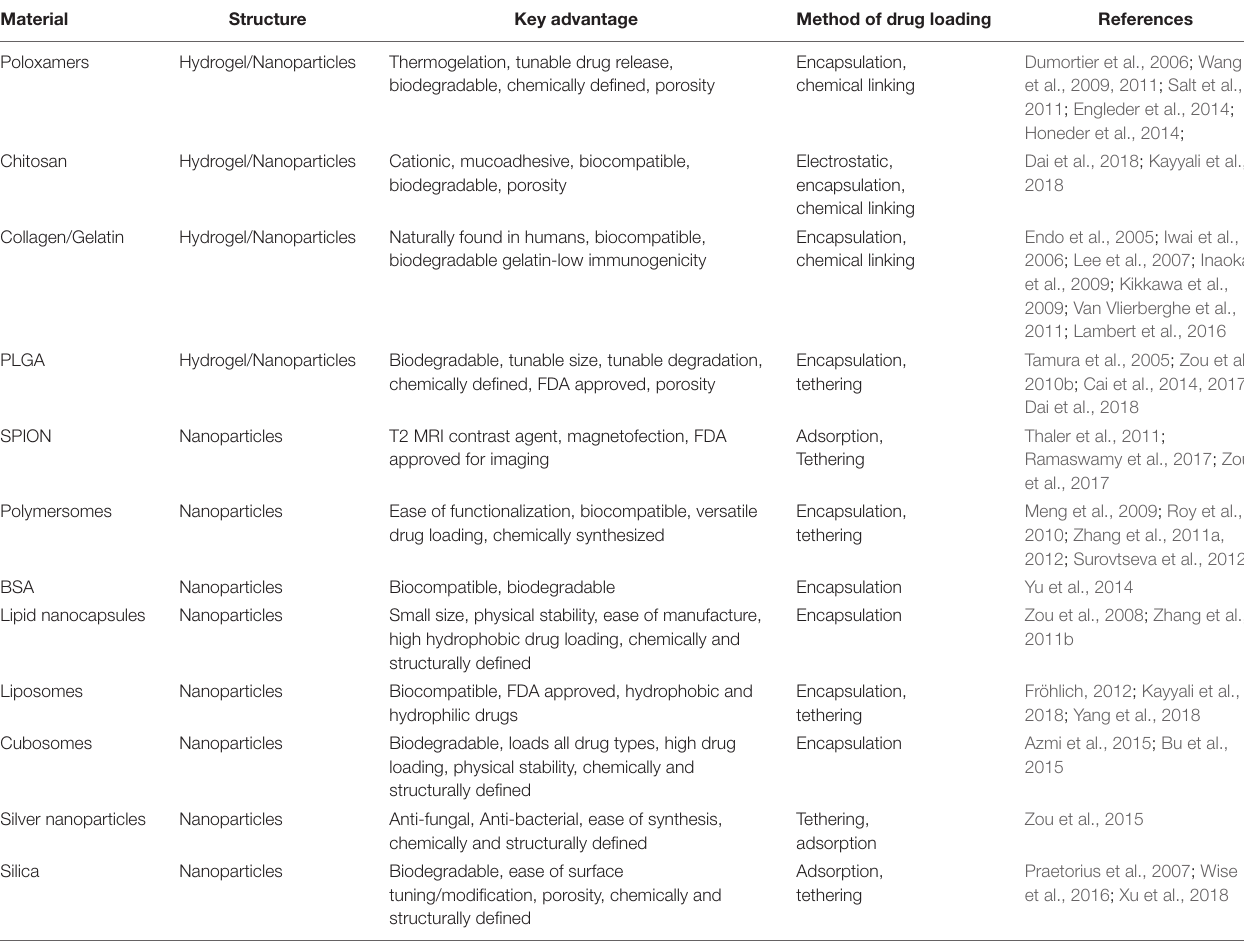
TABLE 1 | Common biomaterial used for drug delivery to the inner